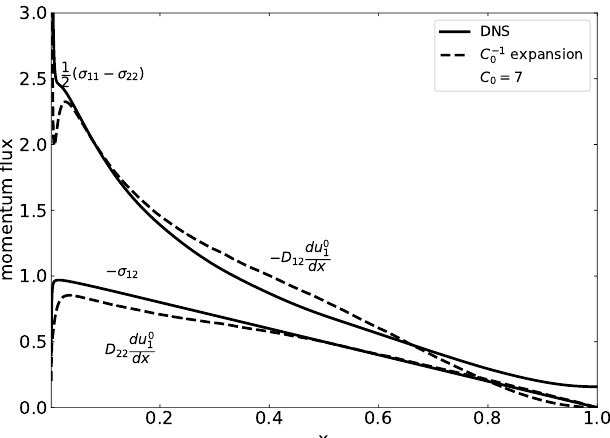
Figure 2. The mean momentum fluxes versus the dimensionless distance from wall. The values of σ 11 , σ 22 and σ 12 are obtained using DNS and are represented by full lines. The values of D 12 ( d / dx ) u 0 and D 22 ( d / dx ) u 0 result from the C − 1 expansion and are represented by broken lines. They follow from 0 1 Equations (69), (71) and (72) in which the right-hand sides were evaluated using the DNS